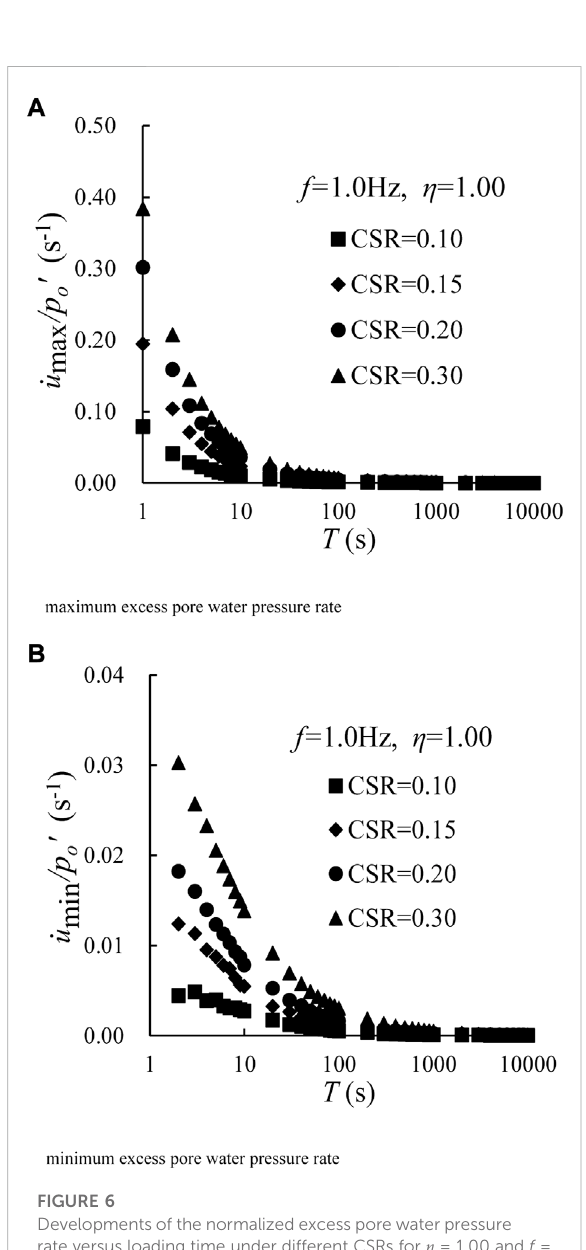
FIGURE 6 Developments of the normalized excess pore water pressure rate versus loading time under different CSRs for η = 1.00 and f = 1.0 Hz. (A) Maximum excess pore water pressure rate and (B) minimum excess pore water pressure